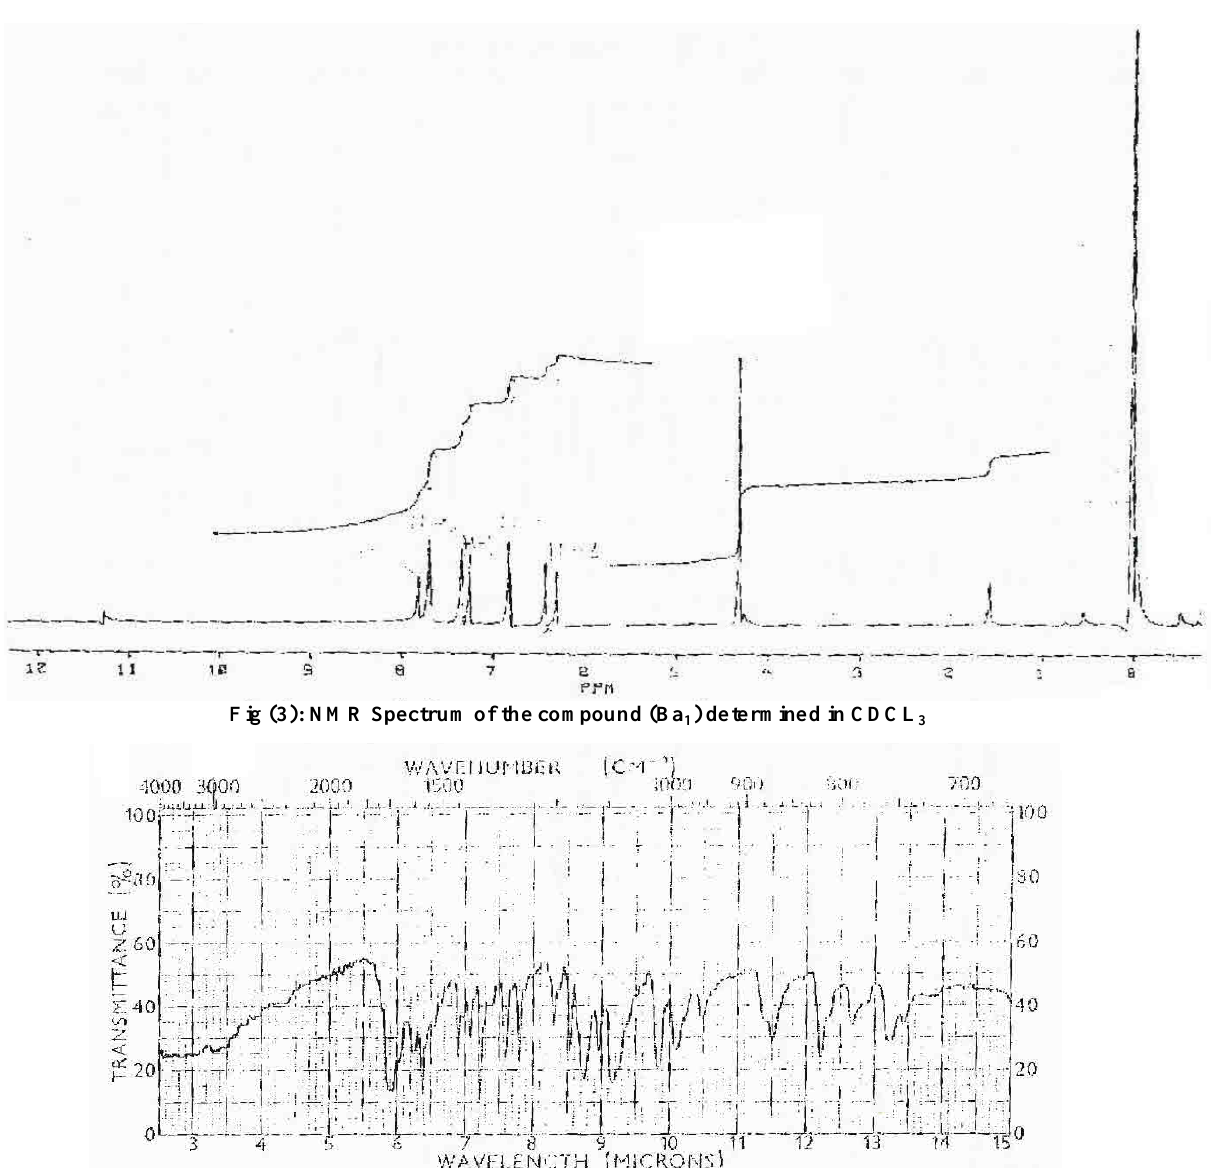
Fig (4) :IR Spectrum of compound